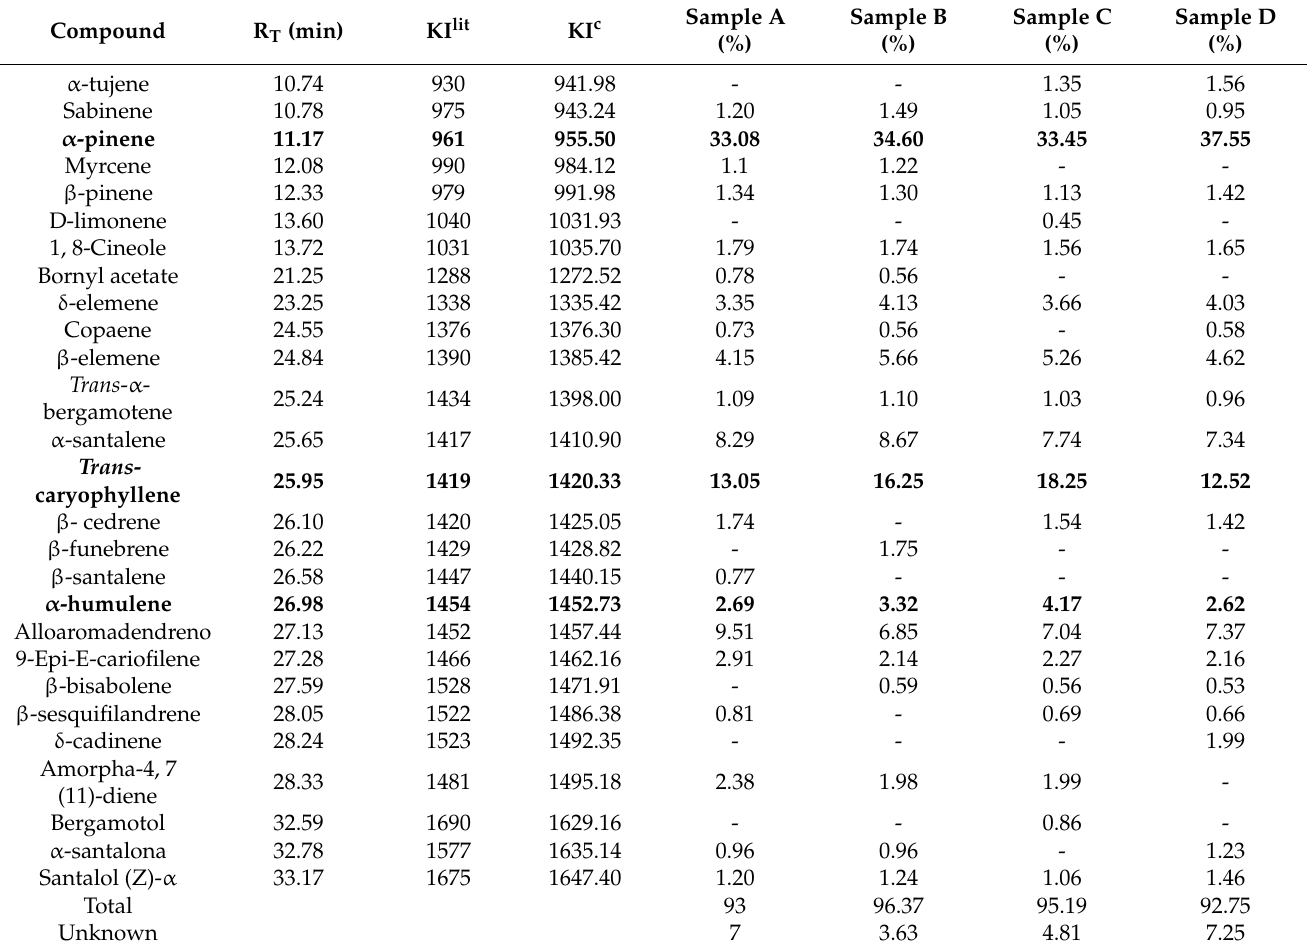
Table 1. Chemical composition of the essential oils from V. curassavica at different ages extracted by steam distillation on an industrial scale. Data were obtained from three independent GC-MS chromatograms and are presented as (%) percentages of area of each substance relative to the total chromatogram.